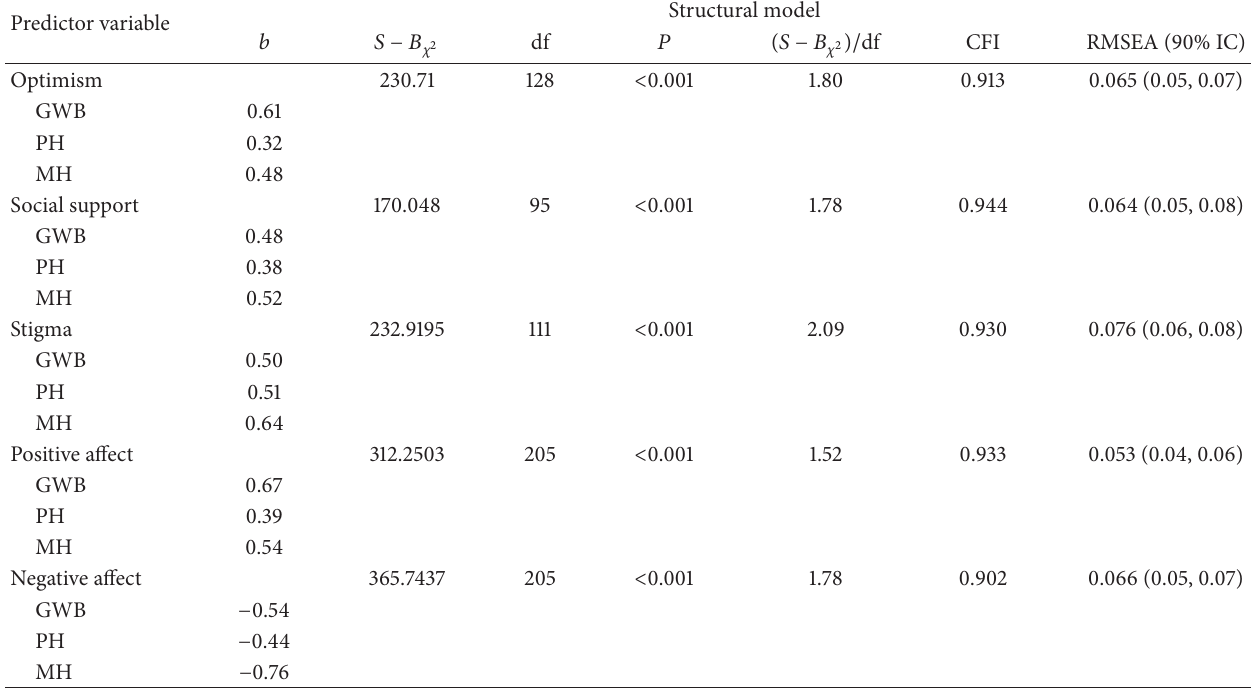
Table 3: Goodness-of-fit test for structural model.